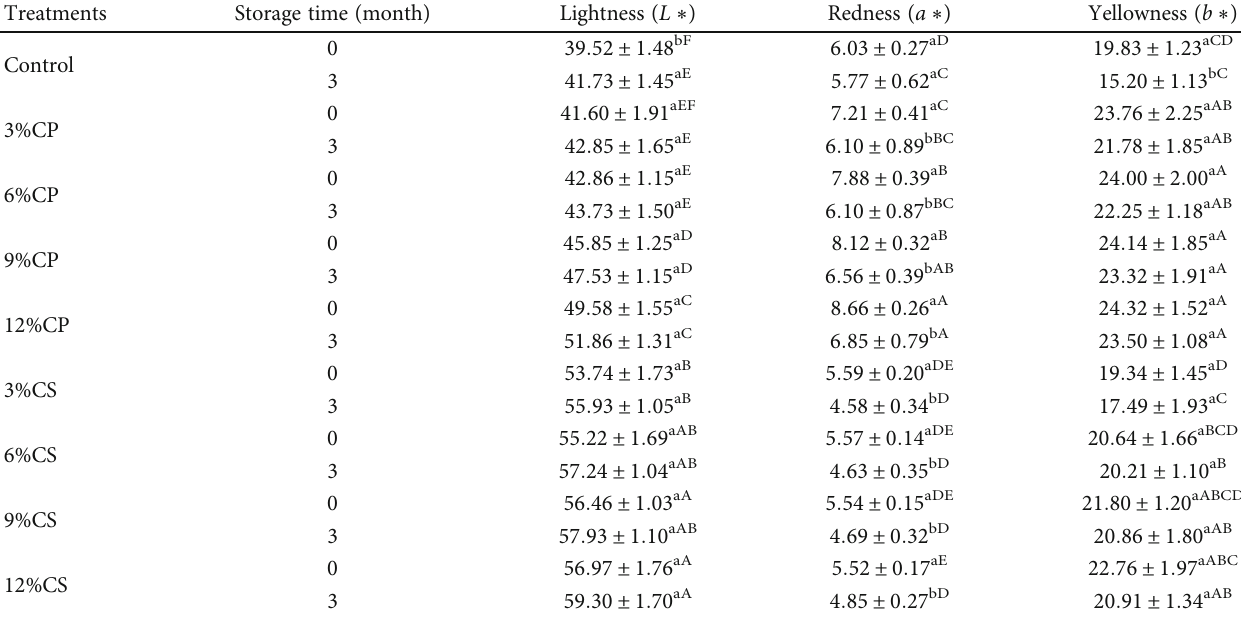
Table 7: Changes in color values of raw chicken patties supplemented with cantaloupe peel (CP) and seeds (CS) powder during storage at -20 for 3 months.